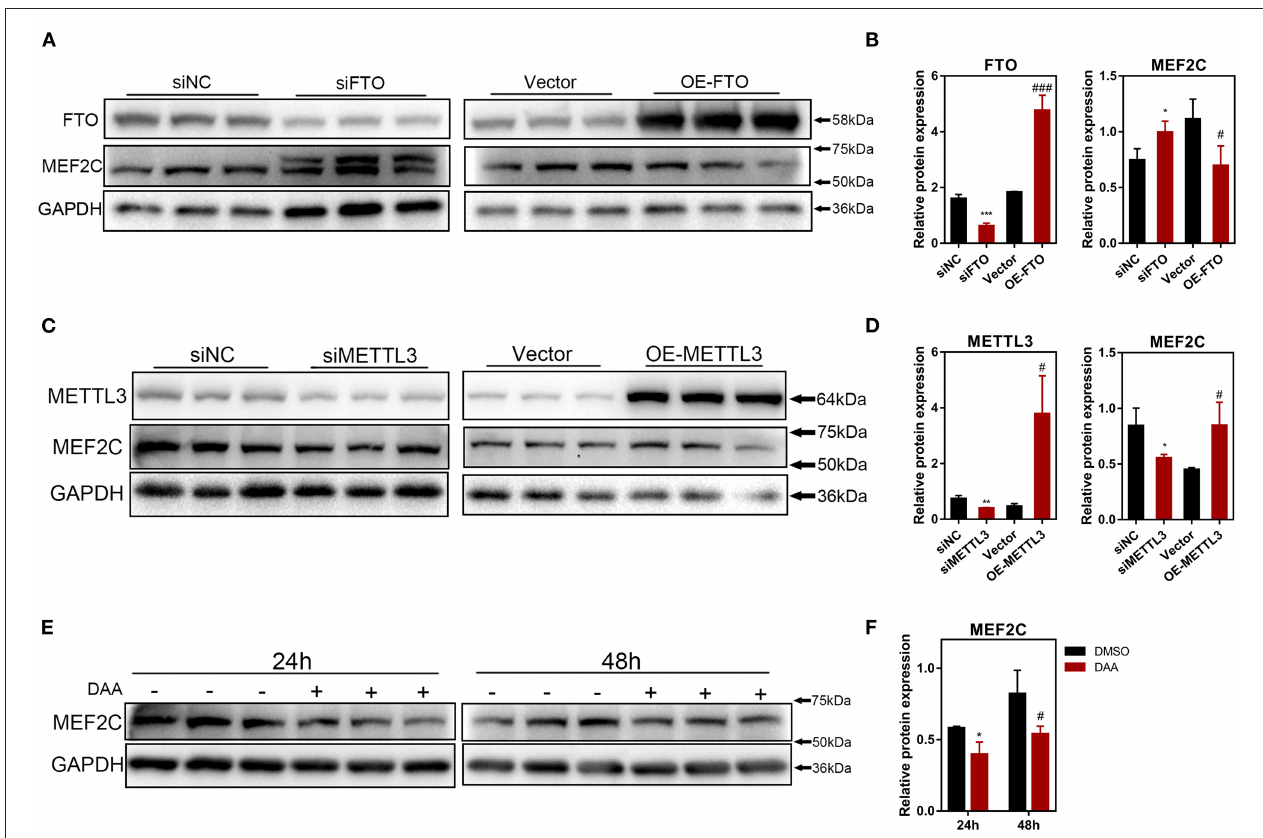
FIGURE 4 | The protein expression of MEF2C is regulated by m6A modification. (A,B) MEF2C and FTO protein levels after FTO knockdown and overexpression on the 4th day after differentiation. (C,D) MEF2C and METTL3 protein levels after METTL3 knockdown and overexpression for 4th day post differentiation. (E,F) Treatment with a global methylation inhibitor, 3-Deazaadenosine (DAA), for 24 and 48h led to the downregulation of the MEF2C protein levels in bovine skeletal myoblasts. The results are presented as the means ± SD (* p < 0.05, ** p < 0.01, *** p < 0.001, siNC vs. siRNA samples and DMSO vs. DAA at 24h; # p < 0.05, ### p < 0.001, empty vector vs. overexpression plasmid samples and DMSO vs. DAA at 48h), using Student’s t